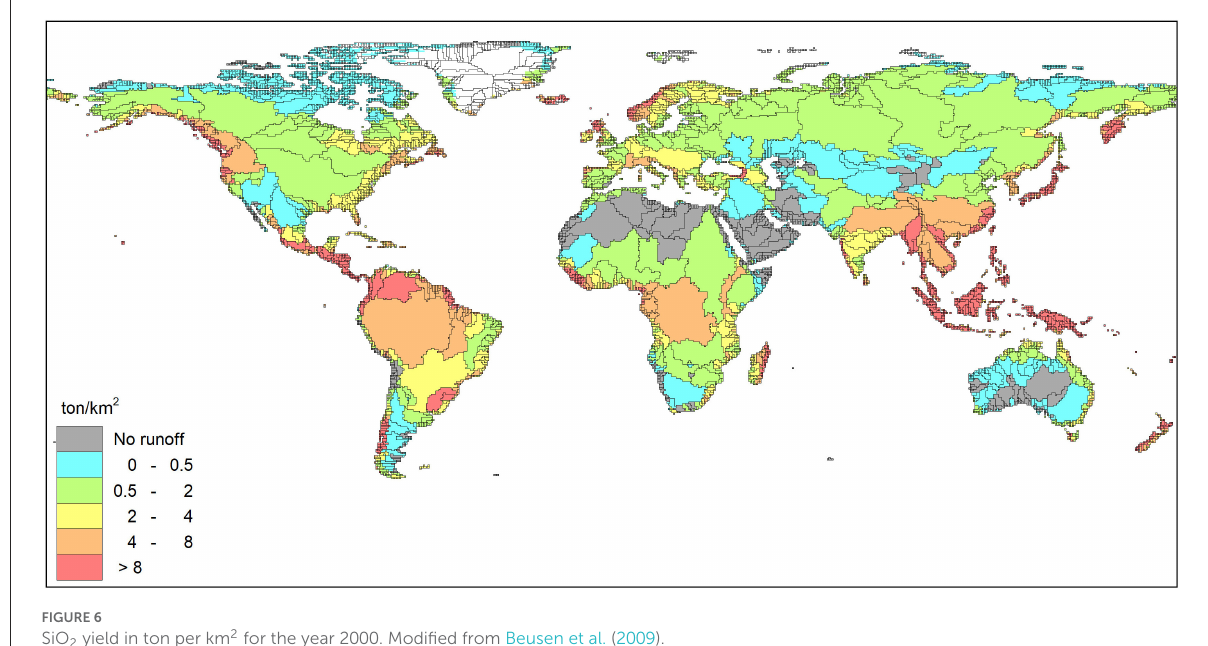
increasing, which results in a increasing delivery of N and P to the